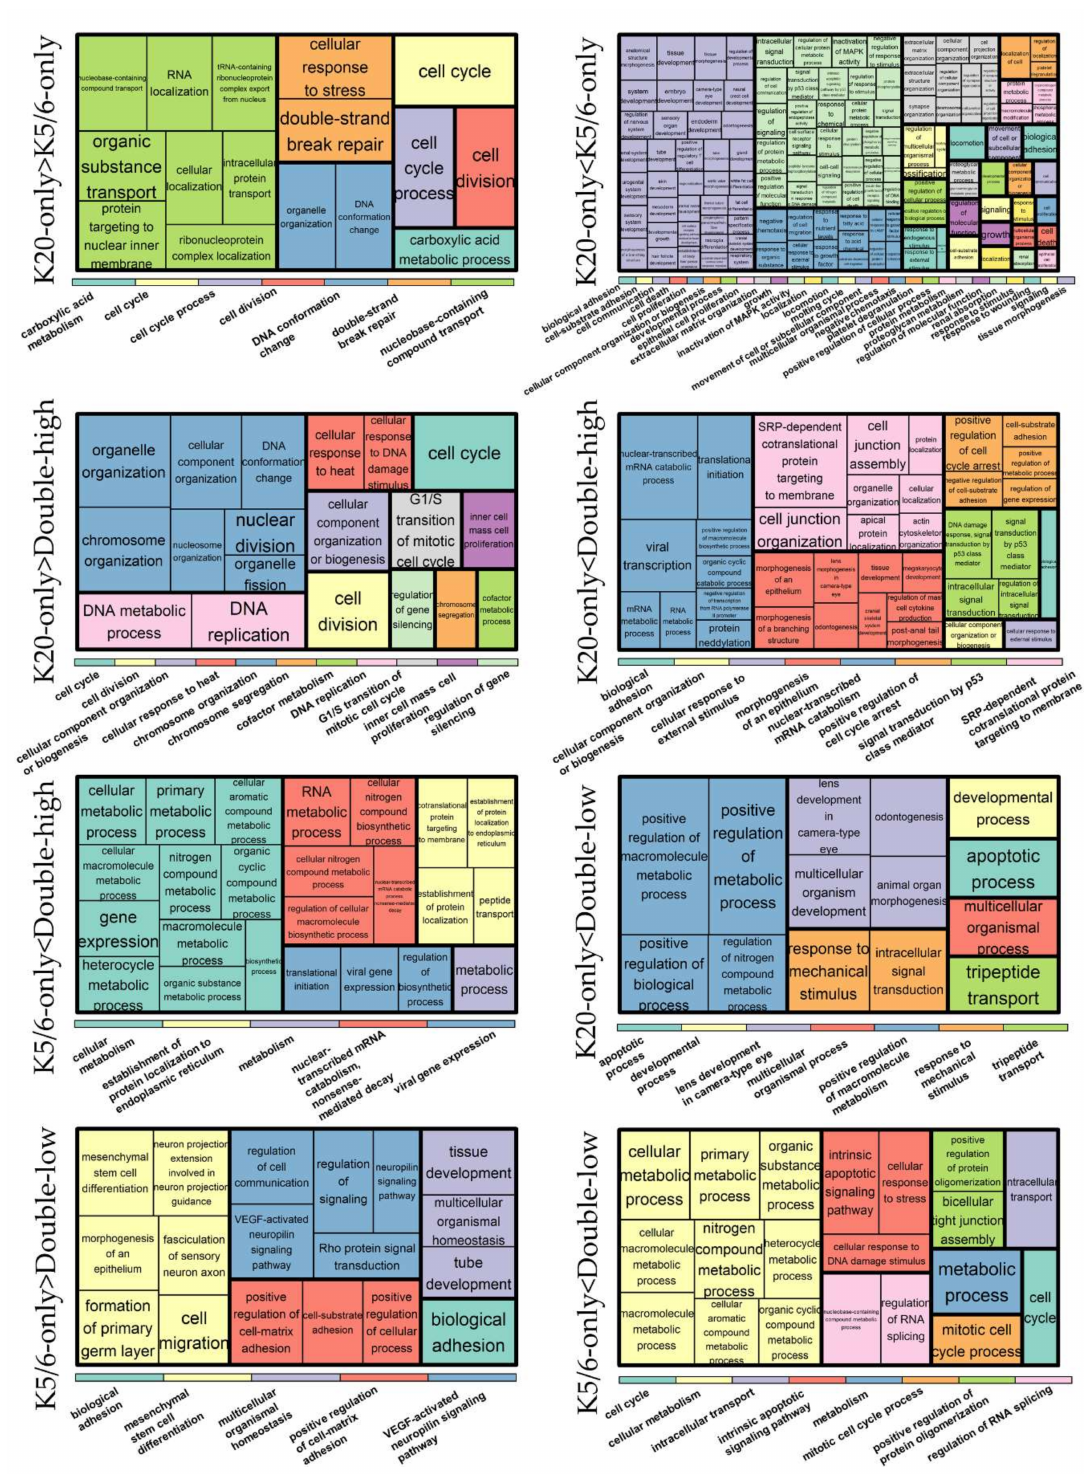
Figure 1. Gene ontology-biologic processes enriched in upregulated genes in each comparison. The relative size of the rectangles represents statistical significance levels. The overarching gene ontology categories are demonstrated with color